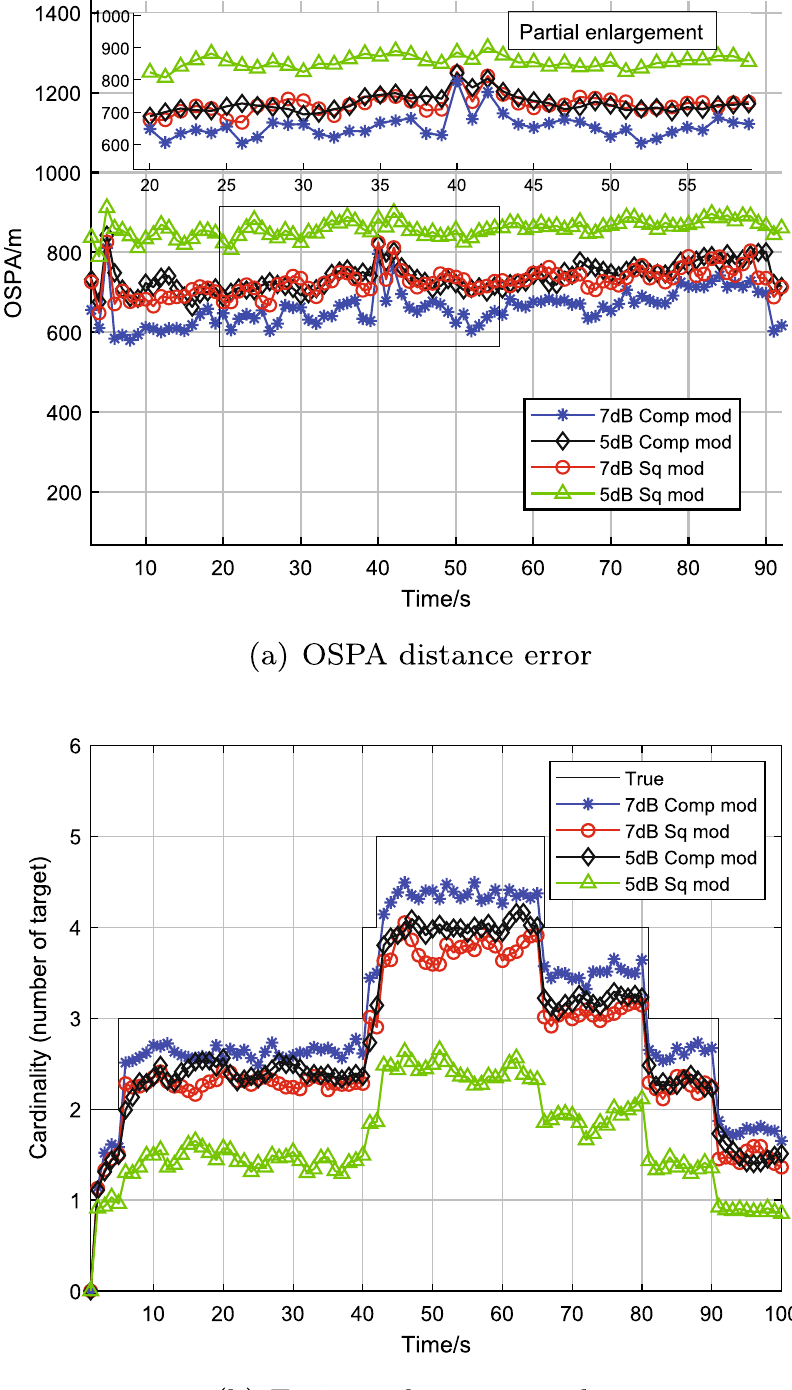
Fig. 12 Two likelihood ratio algorithms with different SNR ratios under Swerling